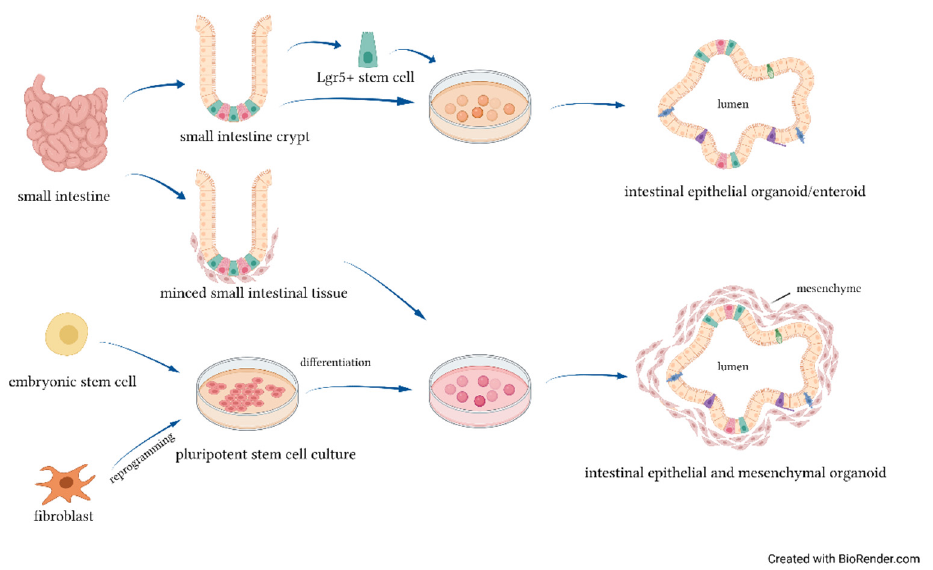
Figure 1. Intestinal organoids’ cellular sources.